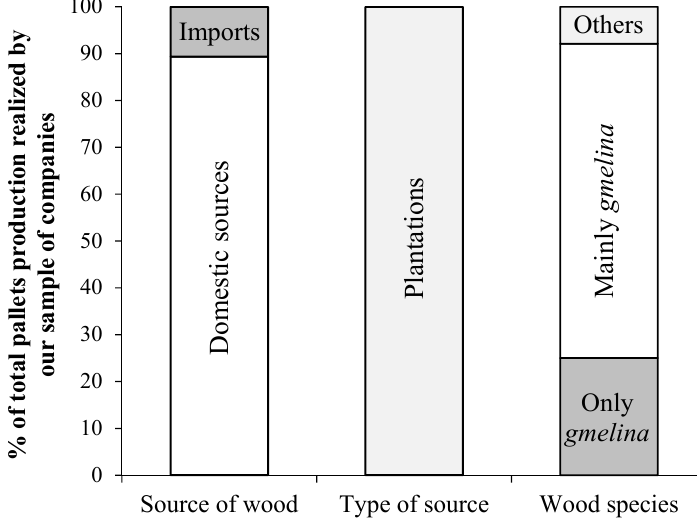
Figure 4. Proportion of the different sources and species of wood used by the nine interviewed companies that produce and sell new wood pallets, expressed as the proportion of total production accounted for by this sample of companies.